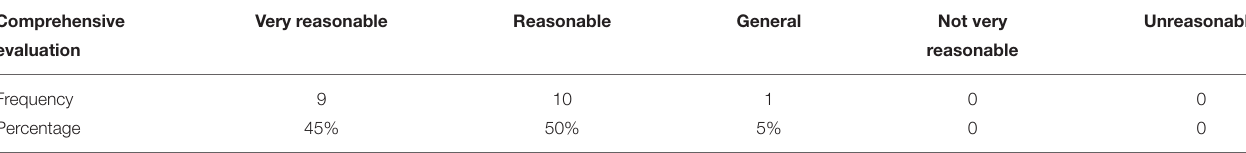
TABLE 7 | Validity test table.